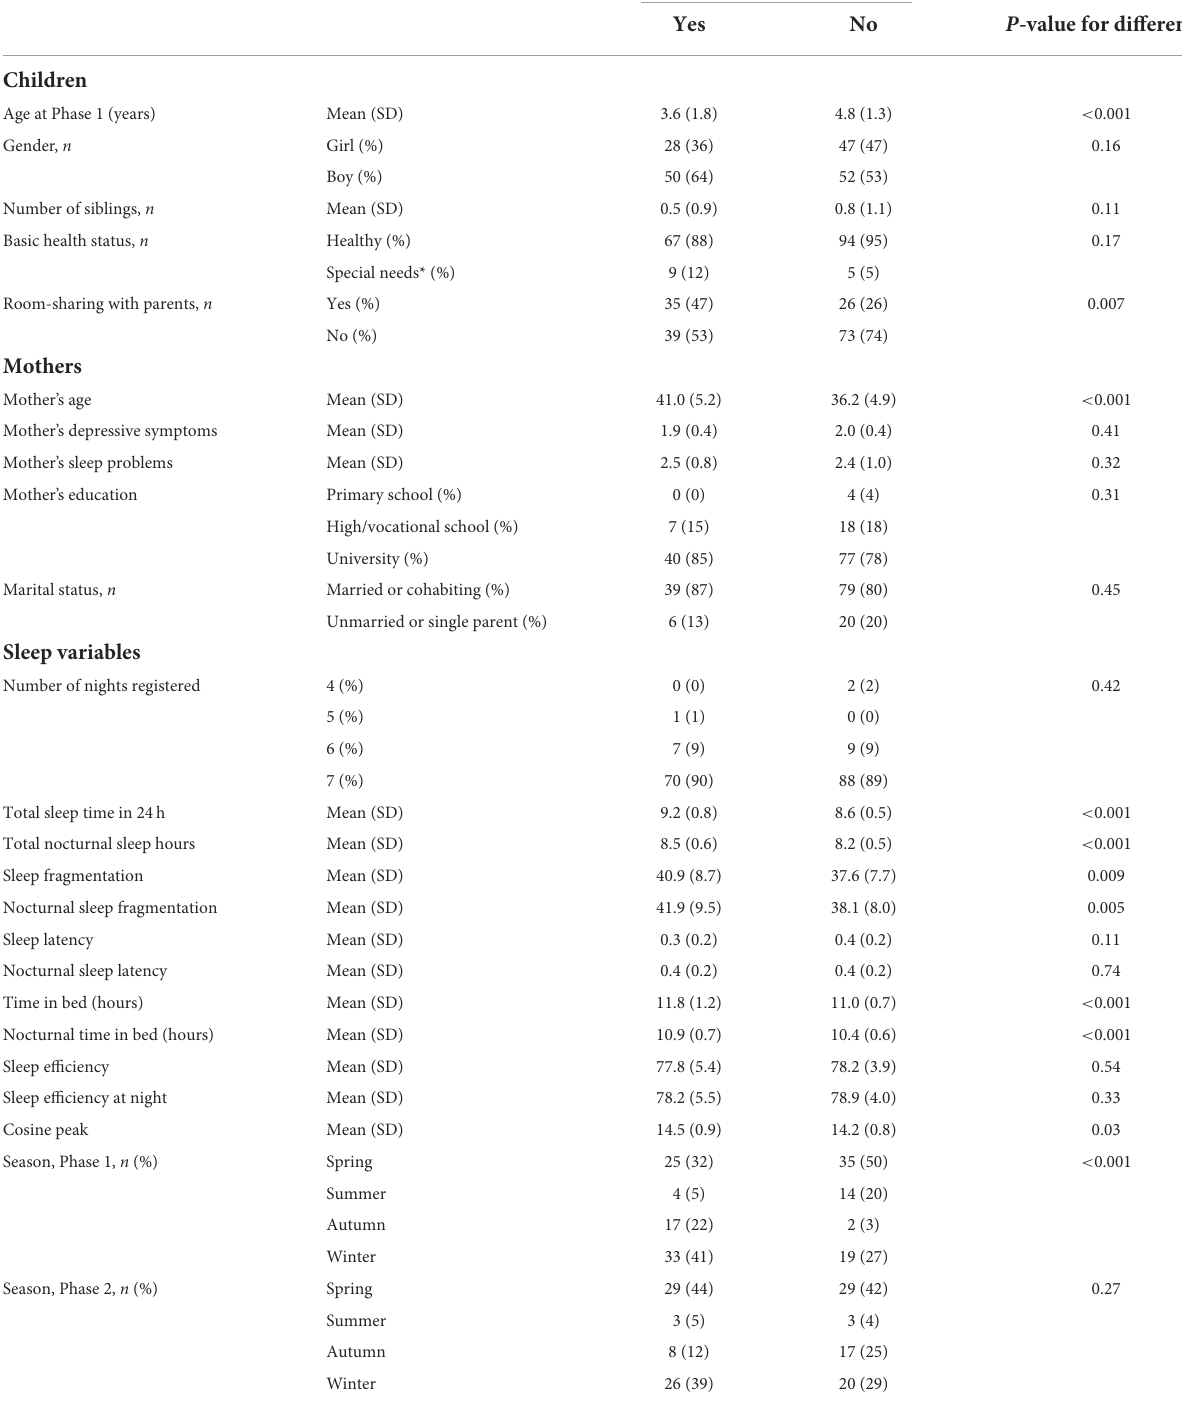
TABLE 1 Participant characteristics based on the adoption